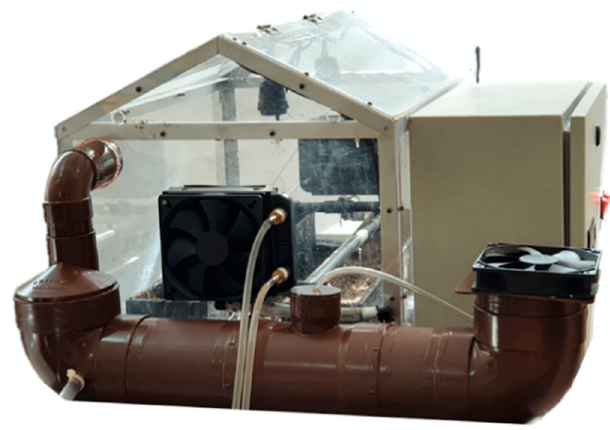
Figure 1. Hood-type micro-greenhouse prototype.